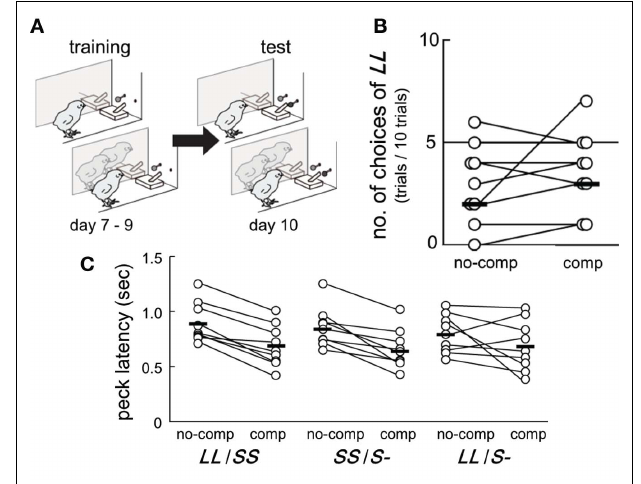
FIGURE 1 | Competition in the test did not instantaneously change inter-temporal choices but shortened the operant peck latency. Data obtained from a group of chicks ( n = 9) are shown. (A) Experimental procedure of training (post-hatch day 7–9) and test (day 10). In both blocks, the subject chick was separated from two other accompanying chicks by a transparent Plexiglas partition. (B) Numbers of choices of LL (out of 10 test trials in total) were recorded in the no-competition and the competition blocks.The order of these two test blocks was counterbalanced. Connected pairs of circles denote individuals, and short horizontal bars indicate the median in the group. (C) Latency of the first operant peck at the colored bead was shorter in the competition block than in the no-competition